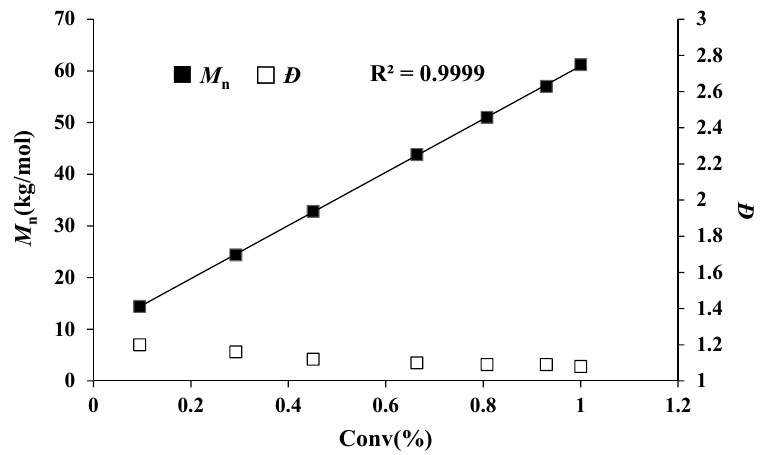
Figure 2. Plots of M n and Ð values of PMMBL samples vs [MMBL] 0 /[ i Bu SKA] 0 ratio at RT. Conditions: [MMBL] 0 /[ i Bu SKA] 0 /[B(C 6 F 5 ) 3 ] 0 = 400:4:1, 400:2:1, 400:1:1, 400:0.5:1, [MMBL] 0 = 0.936 M.